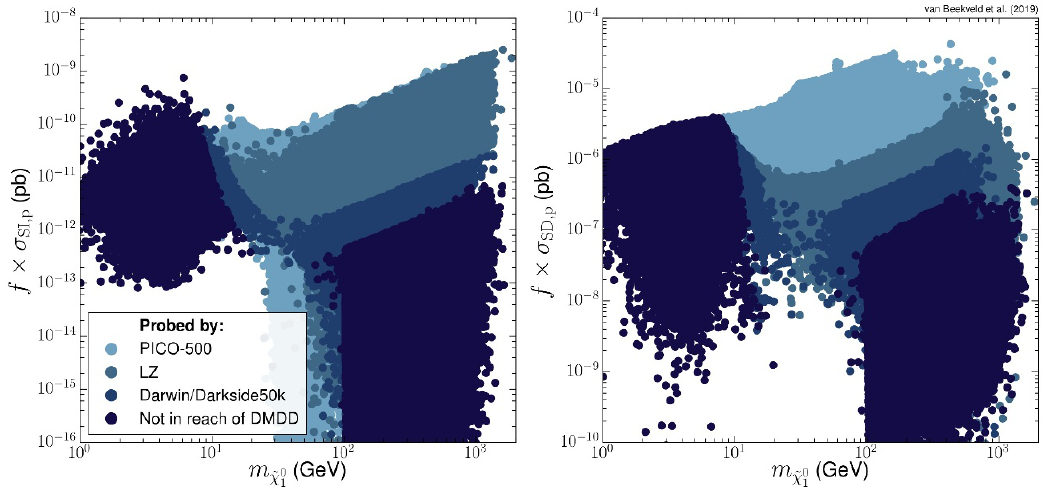
Figure 14 . The mass of ~ (cid:31) 0 in GeV against f(cid:27) SI ; p in pb (right) and f(cid:27) SD ; p in pb (left), where f is 1 the rescaling factor when (cid:10) h 2 < 0 : 12. The color code and plotting order is the same as in (cid:12)gure